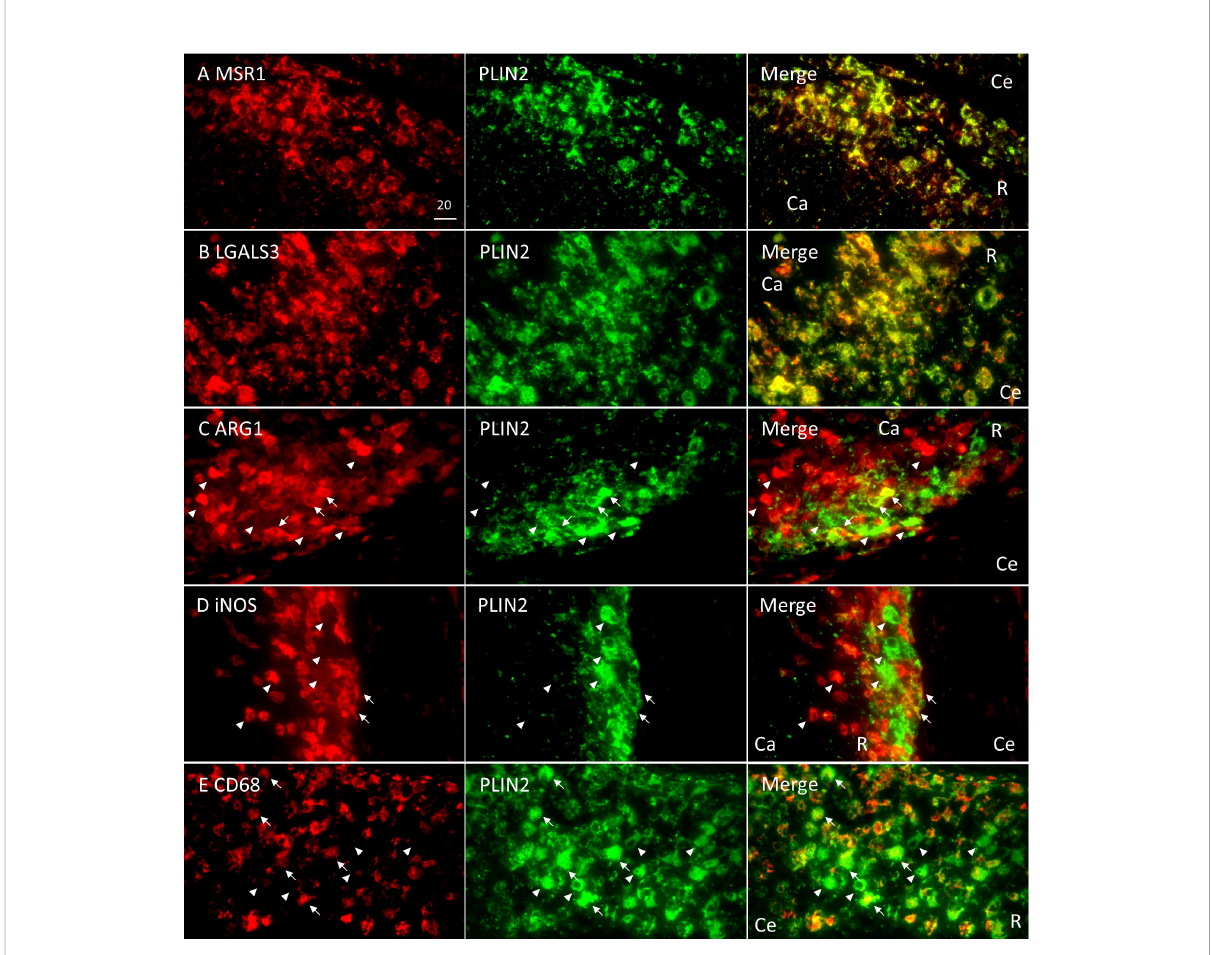
FIGURE 4 Colocalization of Rim signatures and macrophage polarization markers with PLIN2 in Rim region of necrotic granulomas. Immuno fl uorescence microscopy (IFM) was performed to stain necrotic granulomas at 8 weeks p.i. with rabbit anti-MSR1 and guinea pig (GP) anti-PLIN2 (A) , rabbit anti-LGALS3 and GP anti-PLIN2 (B) rabbit anti-ARG1 and GP anti-PLIN2 (C) , rabbit anti-iNOS and GP anti-PLIN2 (D) , and rabbit anti-CD68 and GP anti-PLIN2 (E) antibodies. Arrows and arrowheads indicate both marker and PLIN2-positive cells and either marker or PLIN2 alone-positive cells, respectively. The regions corresponding to Caseum (Ca), Rim (R), and Cell (Ce) of necrotic granulomas are indicated in merged